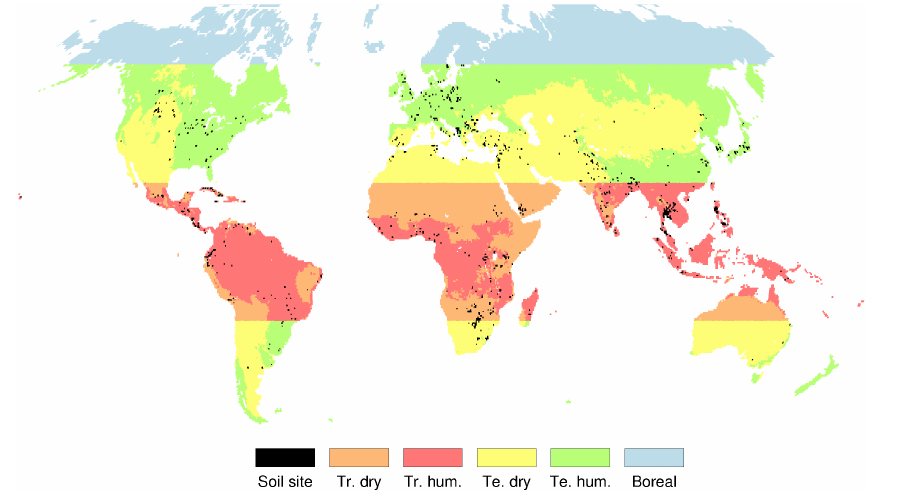
Figure A3. Climatic regions, as defined in Sect. 2.2.1 (tropical dry, tropical humid, temperate dry, temperate humid, boreal). Black pixels show the cropland soil column sites from Batjes (2005), used in the soil carbon comparison in this